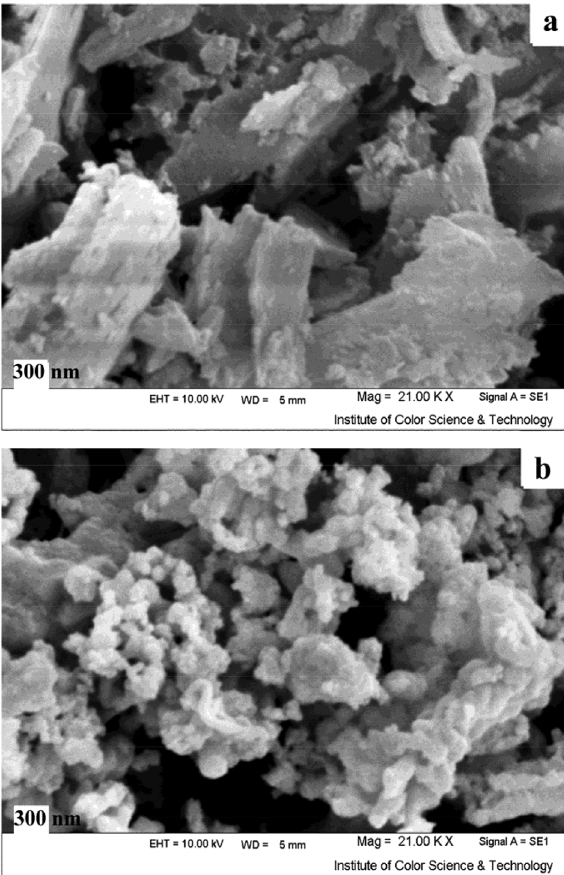
Figure 5: SEM photographs of the BFO NPs calcined at (a) 400ºC and (b)